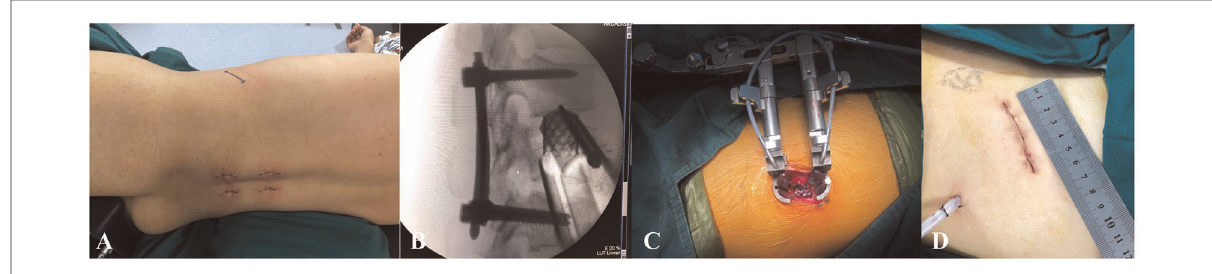
FIGURE 2 Operating room images demonstrating the AIPA surgical procedures. ( A ) Anterior incision of AIPA after posterior pedicle screw fi xation. ( B ) Lateral radiograph demonstrating anterior titanium cage placement. ( C ) Position of the retractor system and the extent of exposure obtained. ( D ) Length of the anterior